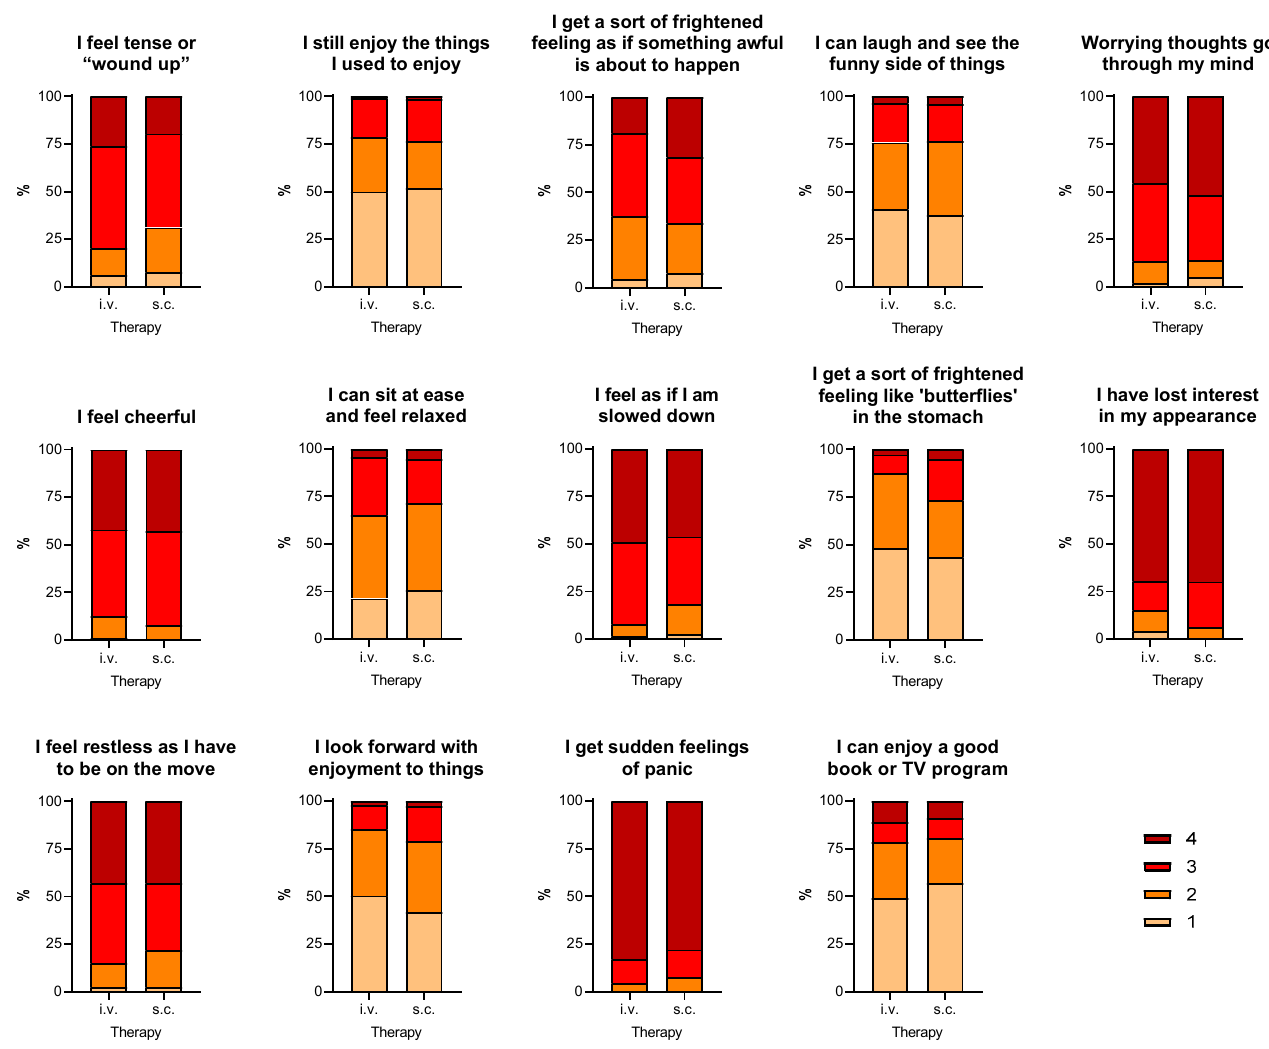
Figure 2. Responses to the HADS questionnaire in IBD patients treated with i.v. or s.c. biological therapy. i.v., intravenously; s.c., subcutaneously.